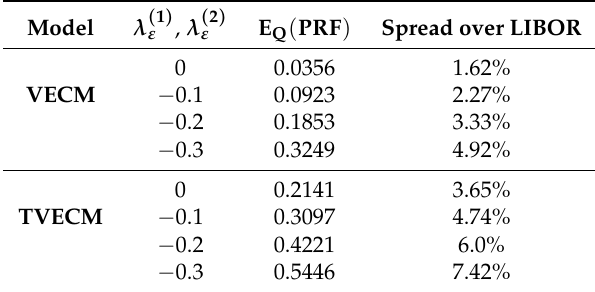
Table 8. E Q ( PRF ) and spread over